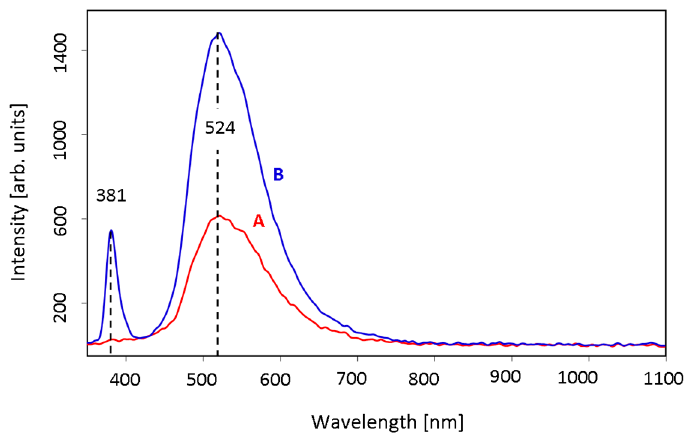
Figure 9. PL spectra of ZnO type A (red) and type B (blue) powders.